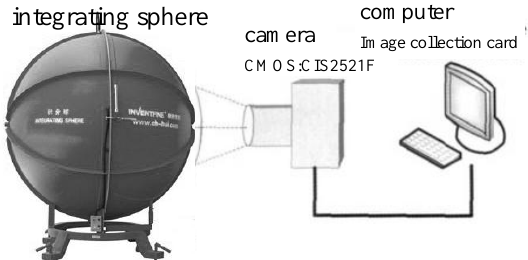
Figure 3. Process of different flat-field image collection using integrating